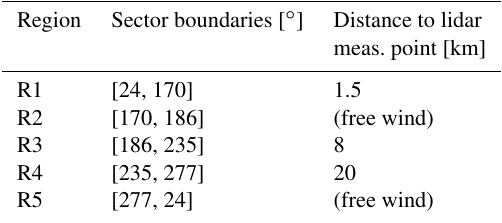
Table 1. Ranges of the individual wind sectors (regions) and dis- tances based on the measurement location of the scanning lidar sys- tem. Region Sector boundaries [ ◦ ] Distance to